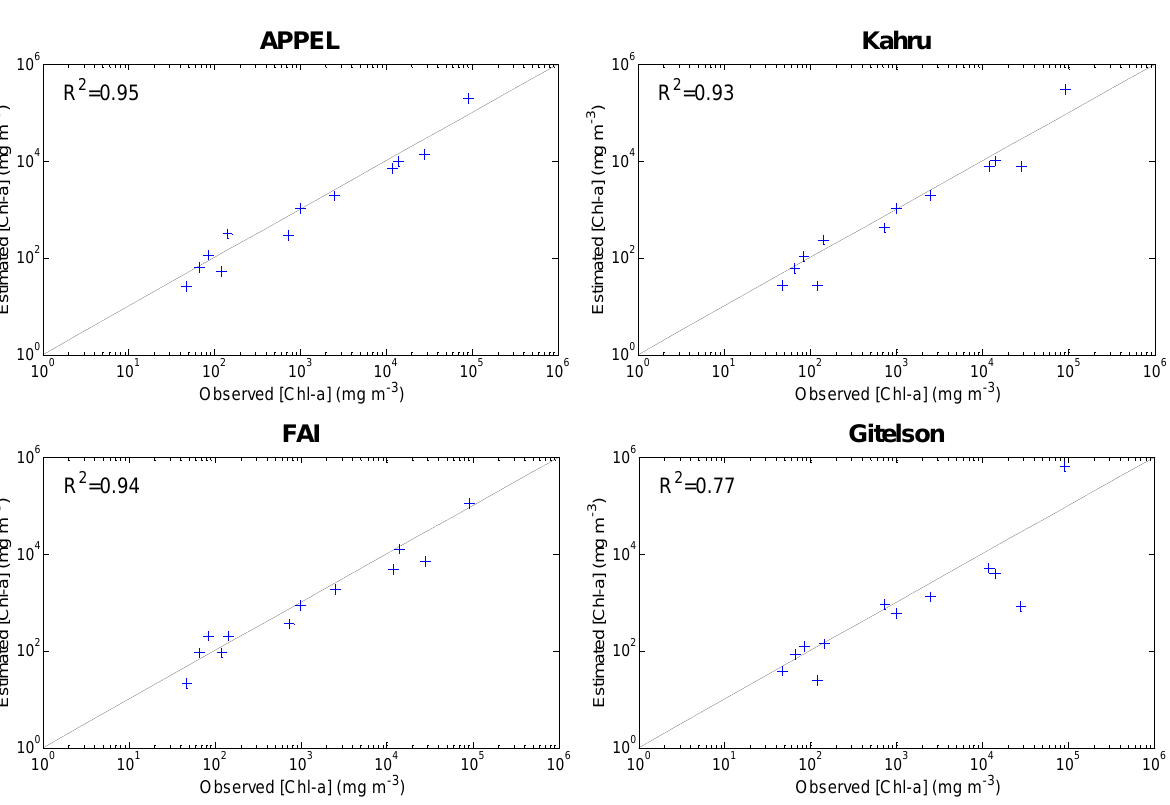
Figure 9. Chlorophyll-a concentration estimated from the four models compared to in situ measurements under heavy bloom conditions (Chl-a > 50 mg∙m –3